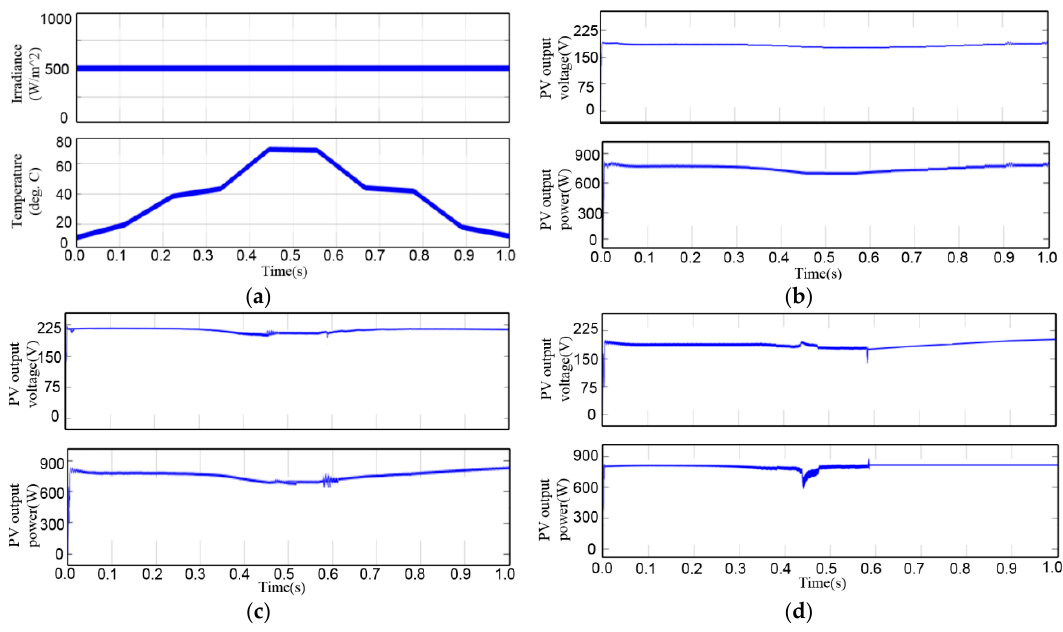
Figure 10. MPPT tracking simulation results of different control methods in variable temperature: ( a ) Change temperature and keep the solar radiation constant; ( b ) VUFLC; ( c ) fuzzy logic control (FLC); ( d ) incremental conductance (INC).